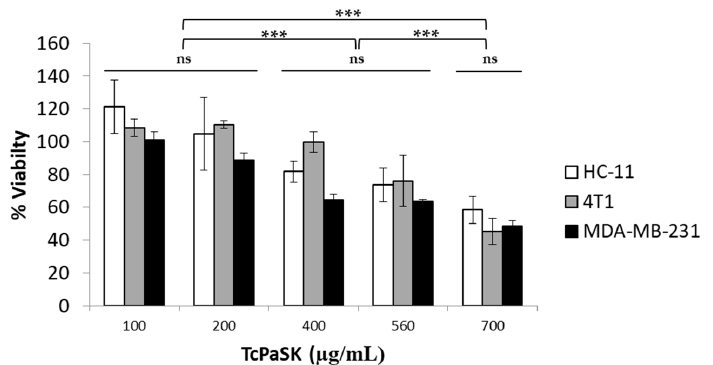
Figure 5. Effect of TcPaSK on mammalian cell viability. Human MDA-MB-231 TNBC cells,